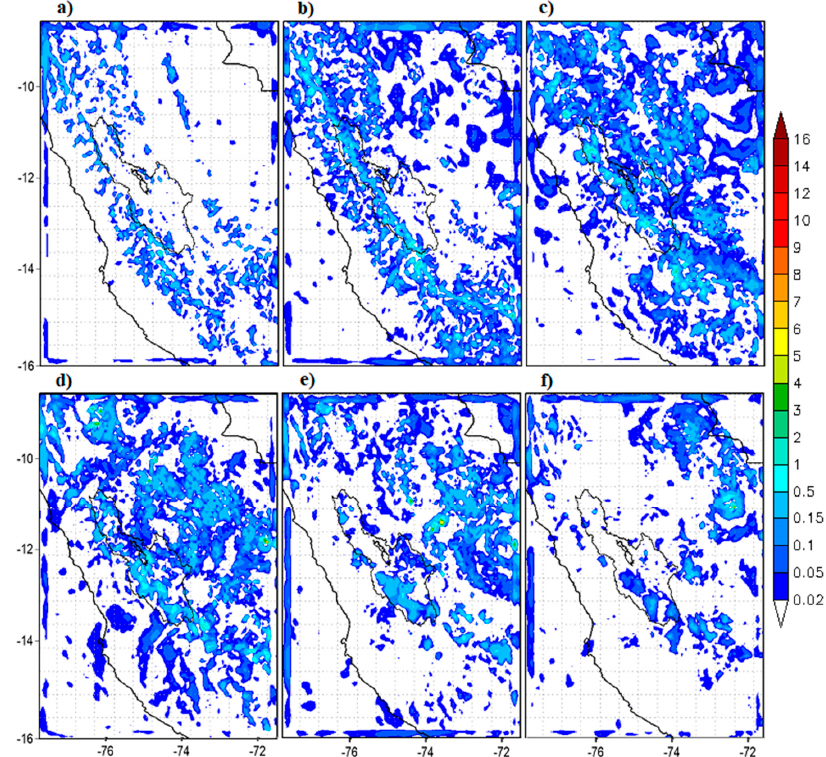
Figure 16. WRF-simulated average vertical velocity in the 600–400 hPa layer (m s − 1 ) over the region at 13 LST, 16 LST, 19 LST, and 22 LST of 2 February 2011 ( a – d ); and at 01 LST and 04 LST ( e , f ) of 3 February 2011.